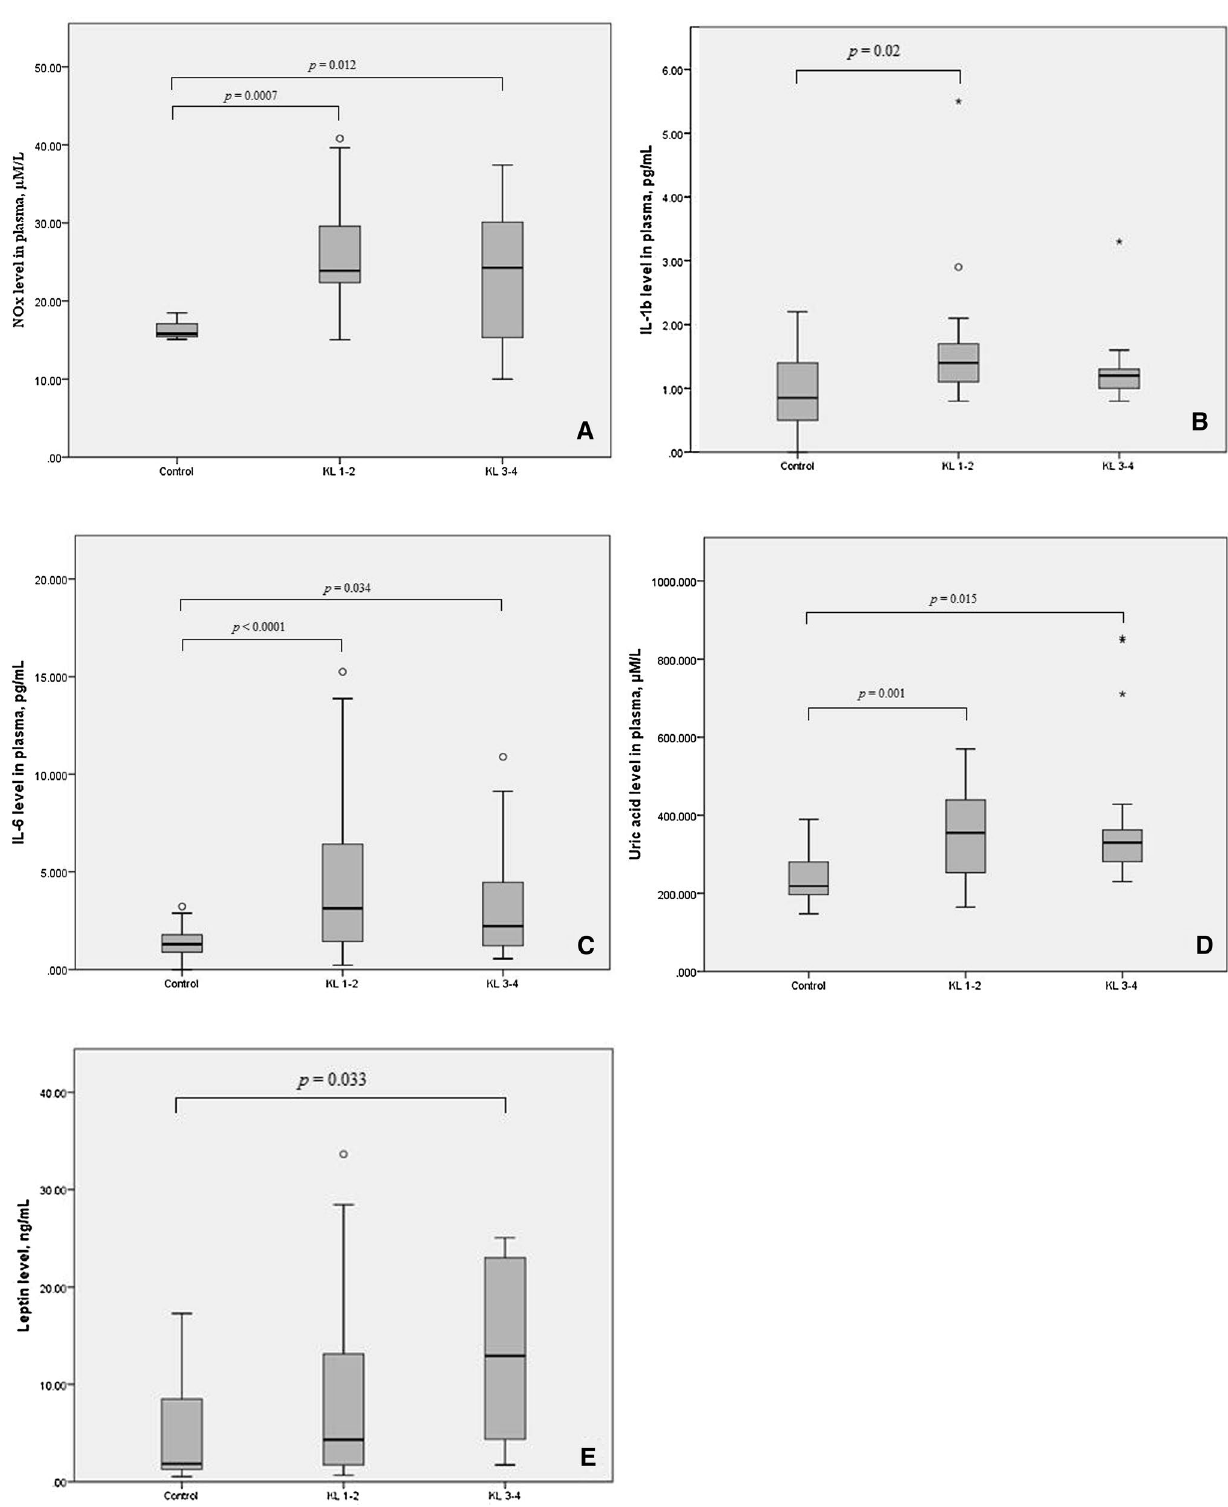
tin level. Boxes indicate the 25 and 75% percentiles; whiskers indicate the minimum to maximum values; bars indicate the median; circles and asterisks indicate